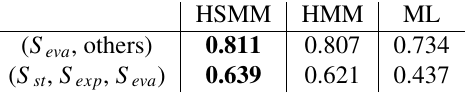
The consistency with the ground truth. The top row indicates the consistency when we consider that the exploration state S exp and the start state S st are the same state. The bottom row indicates the consistency when we discriminate the two